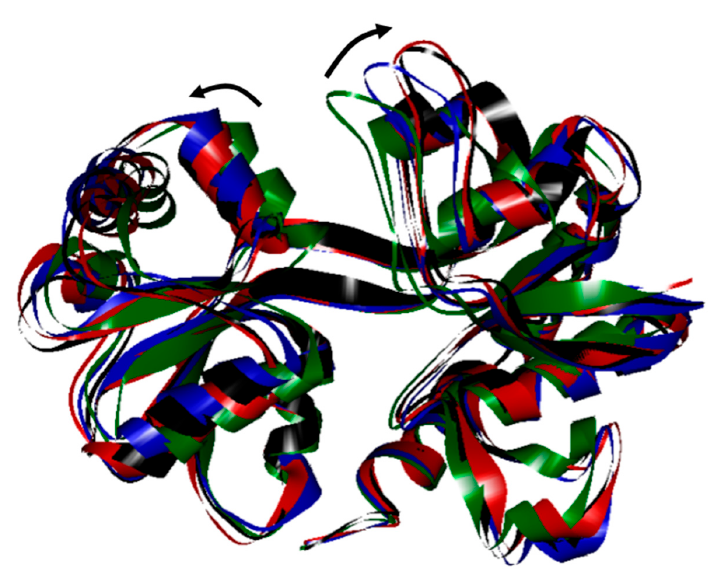
Figure 1. Comparison of structural changes of glutamate receptor 2 (GluR2) during simulation. The green line indicates the crystal structure of GluR2. The blue and red lines represent the structure at 0.4 and 1.2 ns, respectively. The black line represents the final structure of GluR2 at 3.0 ns. The arrows represent the direction of structural change.